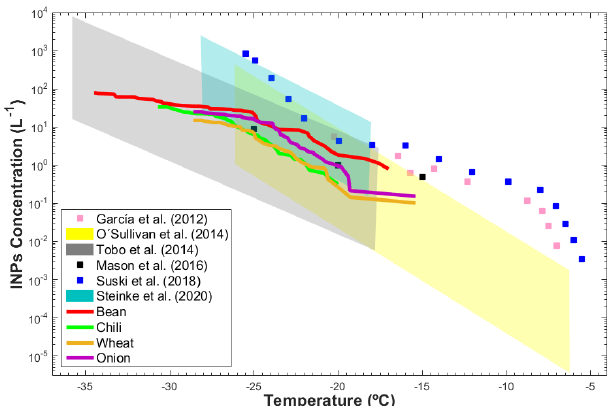
Figure 7. Intercomparison of the INP concentrations from the present study (solid colored lines) and literature data (blue, gray, and yellow areas and filled symbols) as a function of temperature.